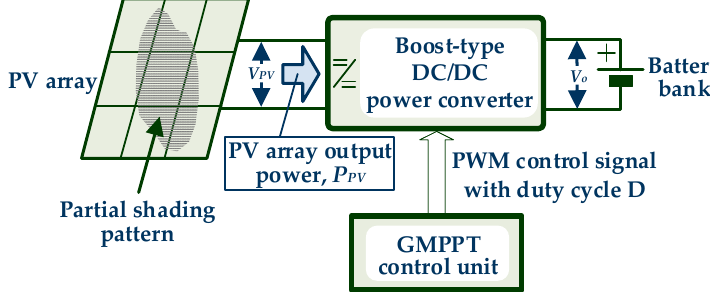
Figure 2. A block diagram of the PV system under consideration.